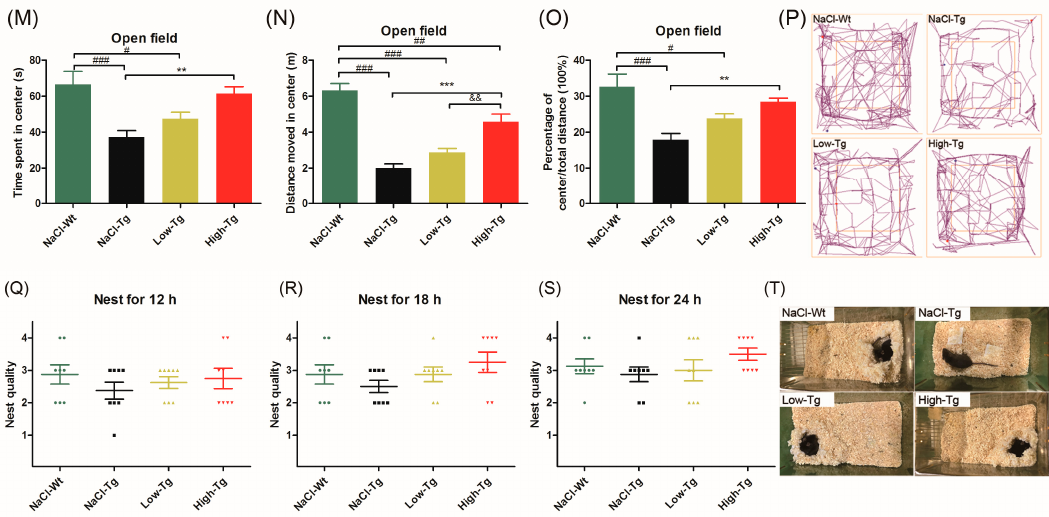
Figure 3. Assessment of the cognitive capacity of APPswe/PSEN1dE9 mice treated with DhHP-6. ( A ) DhHP-6 treatment strategy: APPswe/PSEN1dE9 mice received a daily intraperitoneal injection of 0.3 (Low-Tg) and 3.0 mg/kg (High-Tg) DhHP-6 for 12 weeks. Transgenic mice and wild-type mice mock-treated with NaCl were used as the control (NaCl-Tg) and negative control (NaCl-Wt) groups, respectively. ( B ) Sensorimotor tests were used to evaluate the basic behavior of mice to exclude any effect of the treatment on cognitive tests ( # p < 0.05; * p < 0.05; *** p < 0.001). ( C ) Rotarod test at 20 rpm showed a slower response of the NaCl-Tg mice compared to NaCl-Wt, Low-Tg, and High-Tg groups. ( D ) No significant difference was observed between the groups in the grasping test (D). ( E – H ) Morris water maze test. ( E ) Low-Tg and NaCl-Tg mice needed more time in escaping latency to find the hidden platform compared to the wild-type and High-Tg mice ( # p < 0.05; ** p < 0.01; ### p < 0.001). ( F ) Total number of times the mice passed through the target platform ( # p < 0.05; * p < 0.05). ( G ) Time spent in the target quadrant ( # p < 0.05; * p < 0.05). ( H ) Typical tracks of each group. ( I , J ) Y-maze test. One alternation was defined as the consecutive entry of a mouse into three arms. ( I ) NaCl-Tg showed significant spatial recognition decline compared to the wild-type mice, while both Low-Tg and High-Tg mice showed improvements ( # p < 0.05; * p < 0.05; ** p < 0.01). ( J ) Typical moving tracks in different groups. ( K , L ) Novel object recognition test. ( K ) Low-Tg and High-Tg mice showed more preference for novel objects than for the familiar ones compared to NaCl-Tg mice (* p < 0.05). ( L ) Movement tracks of different groups. ( M – P ) Open field test. Time ( # p < 0.05 ; ### p < 0.001; ** p < 0.01). ( M ), distance ( ## p < 0.01; ### p < 0.001; *** p < 0.001; && p < 0.01) ( N ), relative distance ( # p < 0.05; ### p < 0.001; ** p < 0.01). ( O ), and moving tracks ( P ) spent in the central area. All of the Alzheimer’s disease (AD) mice showed anxiety and less movement in exploring the central zone compared to the wild-type mice, which are effects that were improved by high-dose DhHP-6. ( Q – T ) Nest building. Score statistics of each group at 12 h ( Q ), 18 h ( R ), and 24 h ( S ) after building. ( T ) Typical nest results of each group.